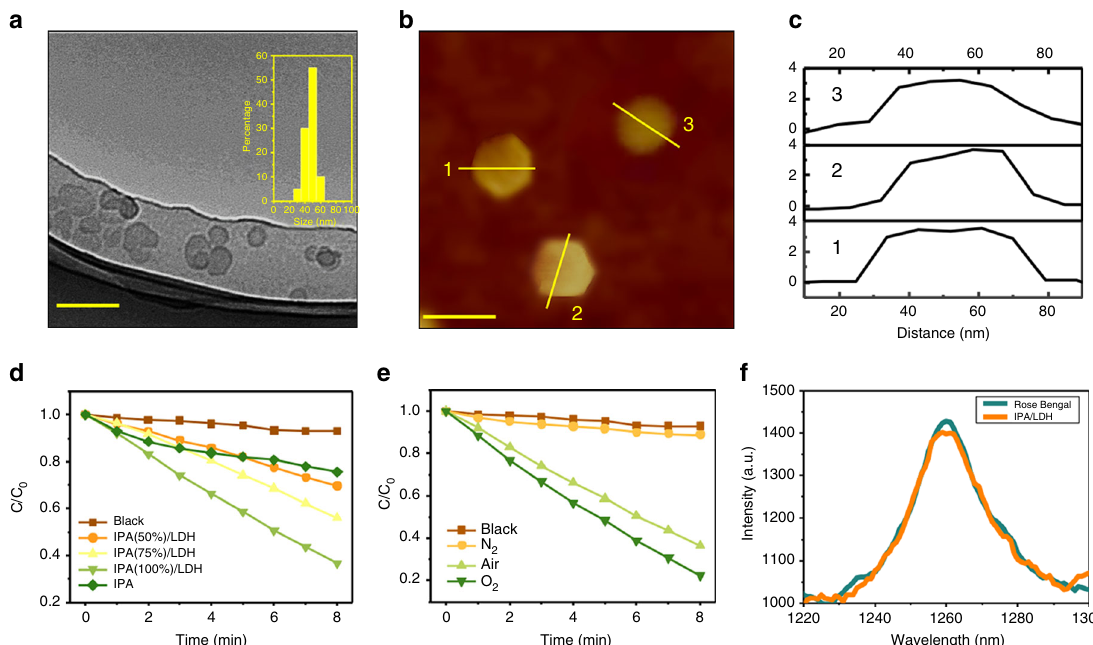
Fig. 3 Structural characterization and evaluation of 1 O 2 production ef fi ciency. a TEM image, Scale bar = 100 nm. b AFM image, Scale bar = 50 nm. c Height curves for IPA/LDH. d Normalized absorbance of DPBF in the presence of IPA, IPA(50%)/LDH, IPA(75%)/LDH, and IPA(100%)/LDH nanohybrids in air. e Normalized absorbance of DPBF in the presence of IPA/LDH under different atmosphere. f 1 O 2 emission at around 1270 nm induced by commercial Rose Bengal and